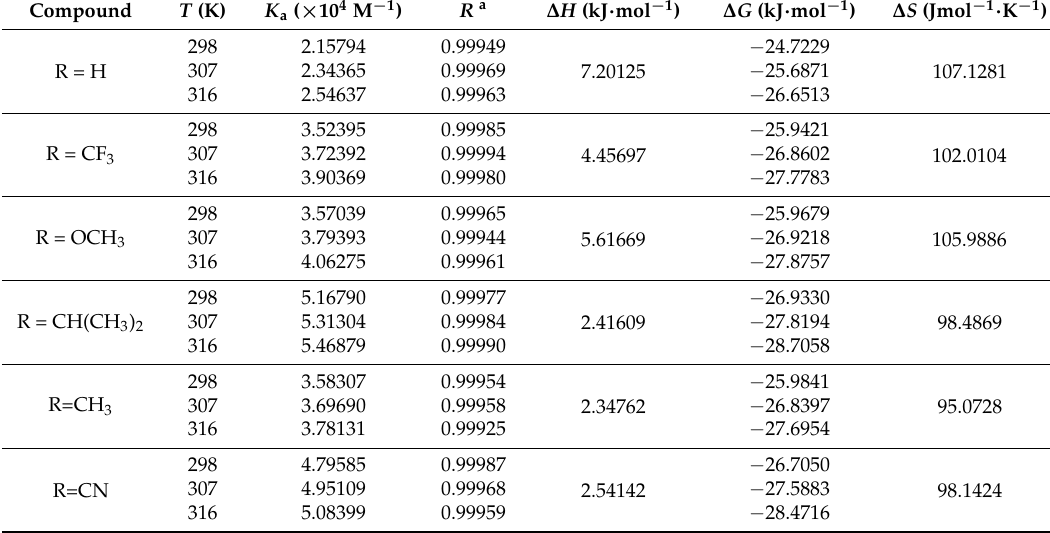
Table 5. Thermodynamic parameters of PDQL-HSA binding systems at different